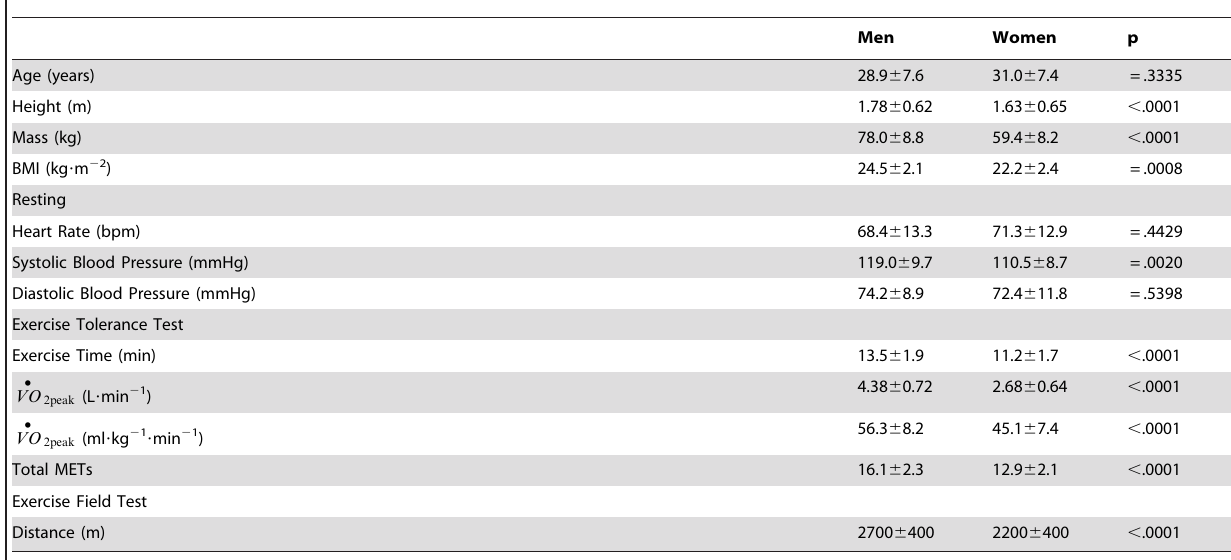
Table 1. Demographic, resting, and exercise parameters of